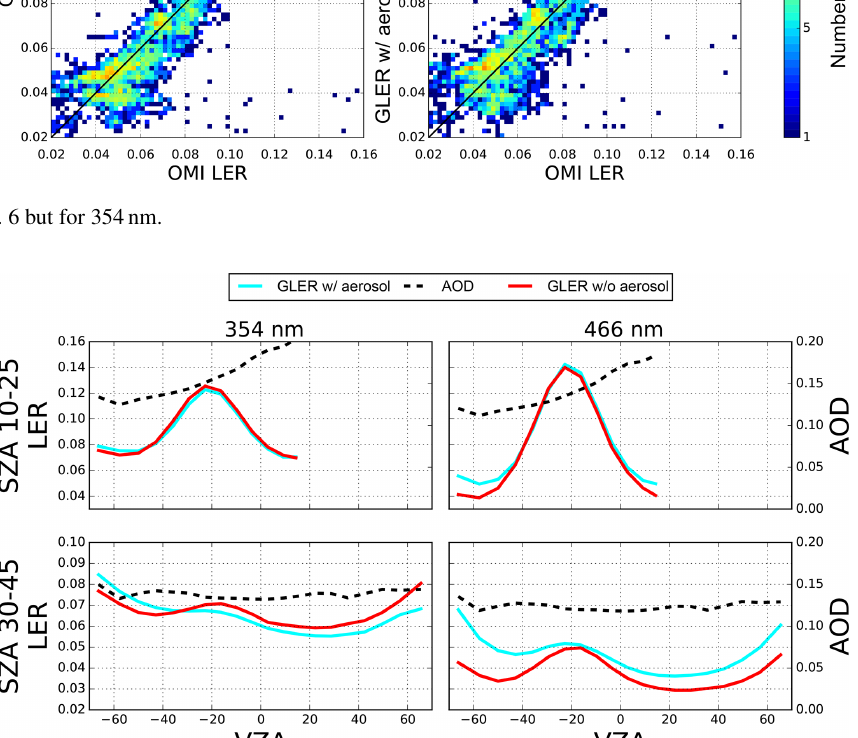
Figure 8. LER as a function of VZA at 354 and 466nm for orbits on 10 April 2006 over the Pacific Ocean. As in Fig. 3 negative VZAs represent the west side of the OMI swath whereas positive VZAs represent the east side of the OMI swath. Since only simulated data are shown, no cloud or aerosol screening is performed.